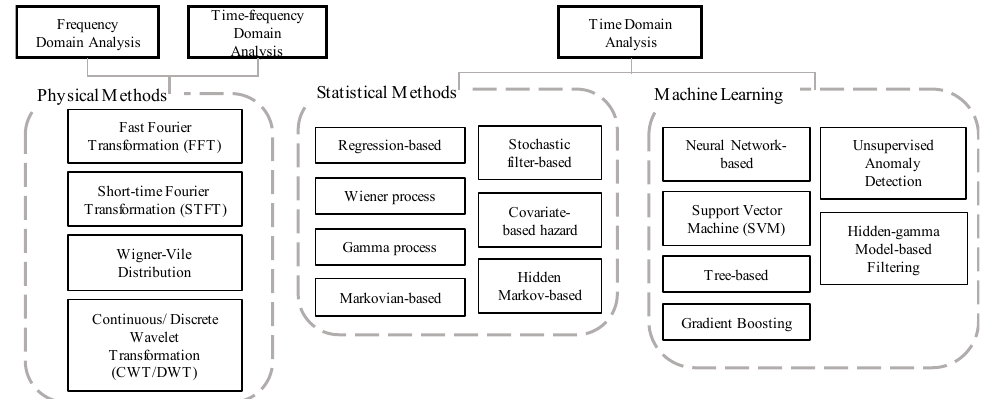
Figure 1. Summary of RUL prediction methods